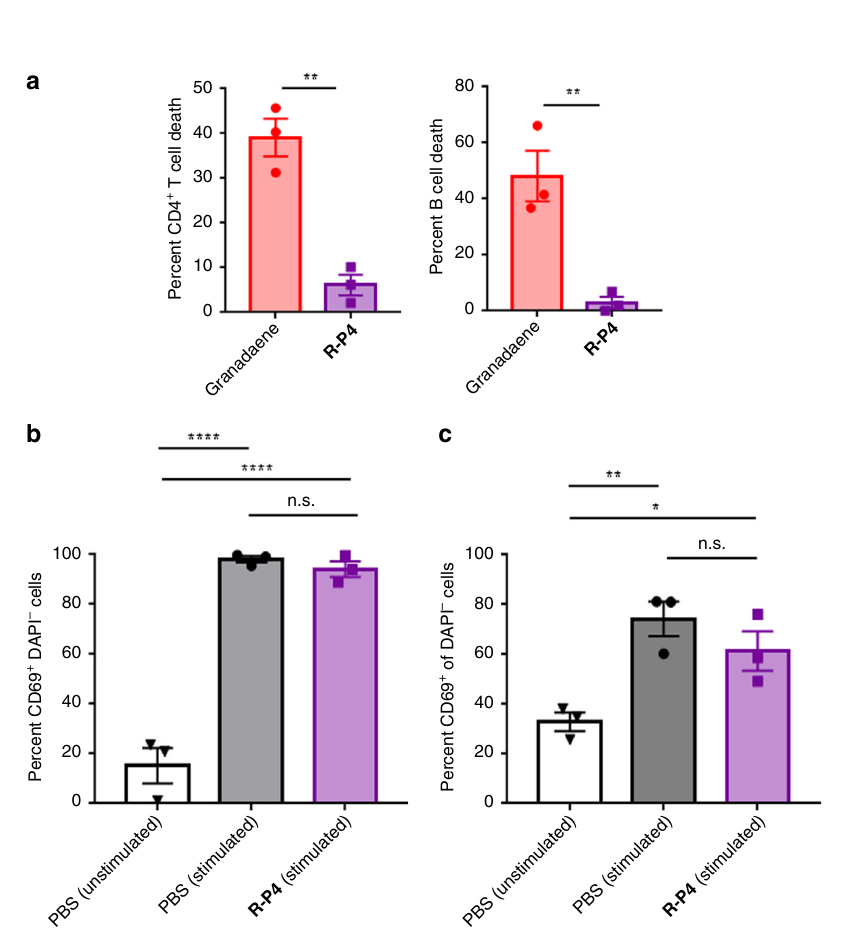
Fig. 4 R-P4 is non-toxic to T and B cells. a Primary human CD4 + T cells (left) and B cells (right) were incubated with R-P4 (20 μ M) or granadaene (0.5 μ M) for 1 h at 37 °C, and cytotoxicity was measured by LDH release into cell supernatant relative to 100% lysis (Triton X-100 (0.1%)) and 0% lysis (PBS) controls. Mean and standard error from three independent experiments are shown. Groups were compared with a two-tailed unpaired t test. CD4 + T cells: p = 0.0024, B cells: p = 0.0084. b Primary human CD4 + T cells were treated with PMA (10 ng/mL) and anti-CD3 ε (100 μ g/mL) (stimulated) or media alone (unstimulated). Then, cells were treated with either PBS or R-P4 (20 μ M) and incubated at 37 °C for 48 h. Cells were stained for CD69, resuspended in DAPI (0.5 μ M), and analyzed by fl ow cytometry. Percent CD69 + of DAPI − cells from three independent experiments are represented with mean and standard error. Treatment groups were compared using one-way ANOVA with Tukey ’ s post test. PBS (unstimulated) vs. PBS (stimulated): p < 0.0001, PBS (unstimulated) vs. R-P4 (stimulated): p < 0.0001, PBS (stimulated) vs. R-P4 (stimulated): p = 0.8151. c Primary human B cells were treated with IL-4 (20 ng/mL) and anti-CD40 (5 μ g/mL) (stimulated) or media alone (unstimulated). Then, cells were treated with either PBS or R-P4 (20 μ M) and incubated at 37 °C for 48 h. Cells were stained for CD69, resuspended in DAPI (0.5 μ M), and analyzed by fl ow cytometry. Percent CD69 + of DAPI − cells from three independent experiments are represented with mean and standard error. Treatment groups were compared using one-way ANOVA with Tukey ’ s post test. PBS (unstimulated) vs. PBS (stimulated): p = 0.0091, PBS (unstimulated) vs. R-P4 (stimulated): p = 0.0453, PBS (stimulated) vs. R-P4 (stimulated): p = 0.3893. *, p < 0.05. **, p < 0.01. ****, p < 0.0001. n.s., Not signi fi cant.